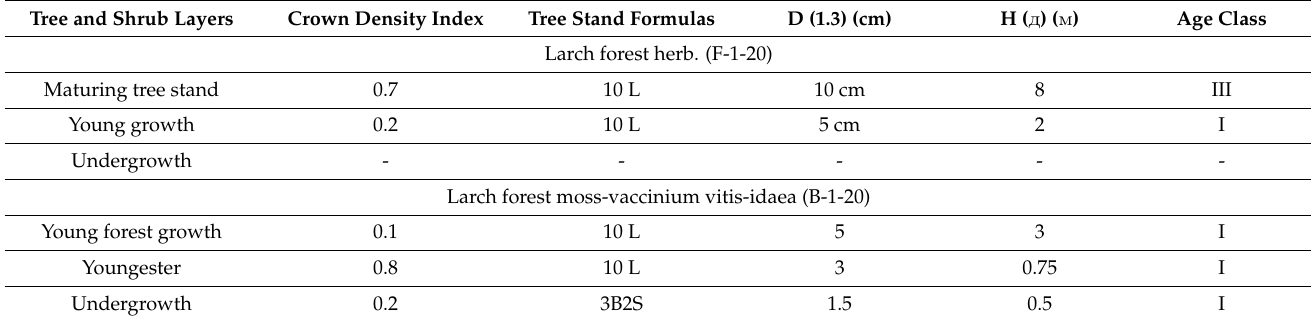
Table 2. The structure of larch forest tree stand.